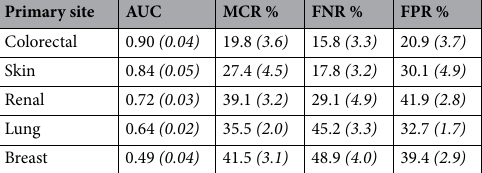
Table 3. Error metrics derived by analysis per BM primary cancer site. 95% confidence intervals provided in